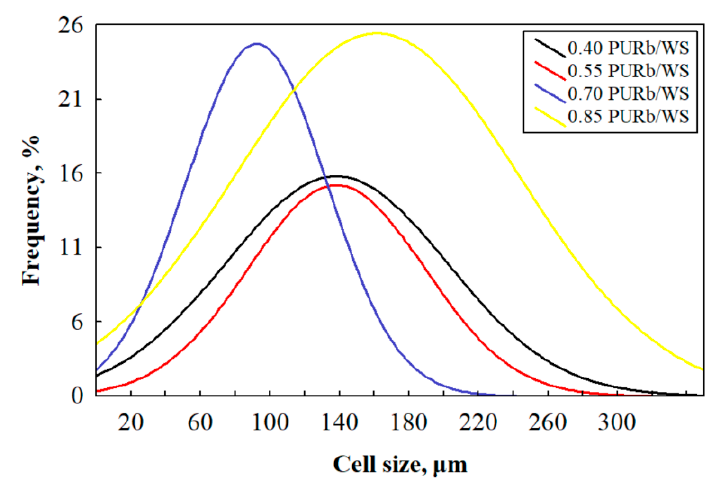
Figure 7. Cell size distribution of PUR biocomposite foams with di ff erent PURb / WS ratios.